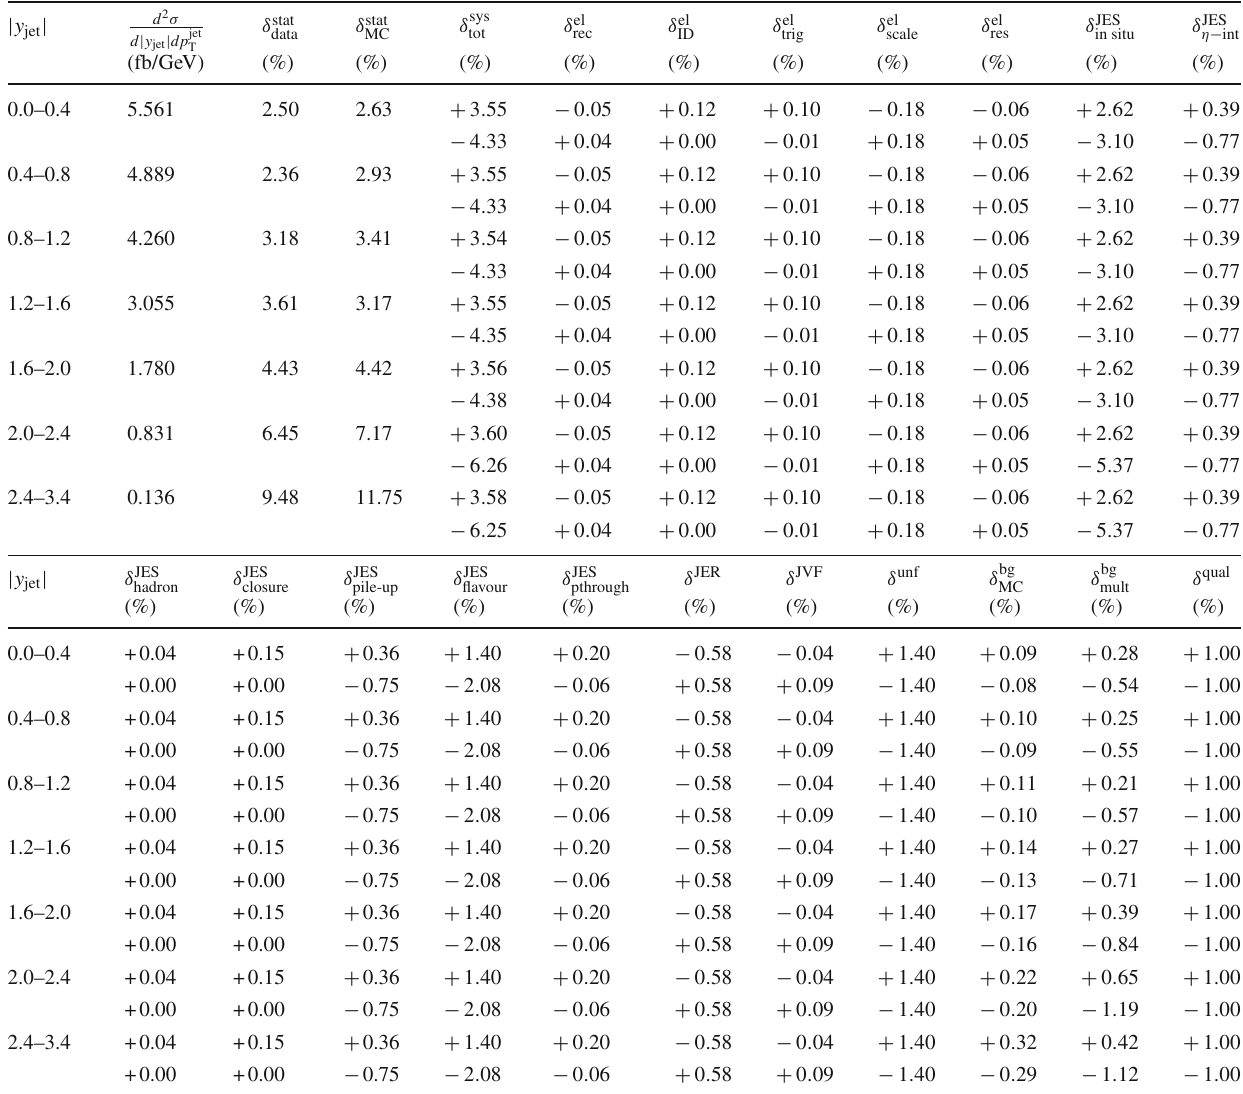
Table 6 The measured double-differential Z + jets production cross- sections as a function of | y jet | in the 200GeV < p jet δ stat and δ stat are the statistical uncertainties in data and MC simulation, data MC respectively. δ sys tot is the total systematic uncertainty and includes the fol- lowing components: uncertainties due to electron reconstruction ( δ el rec